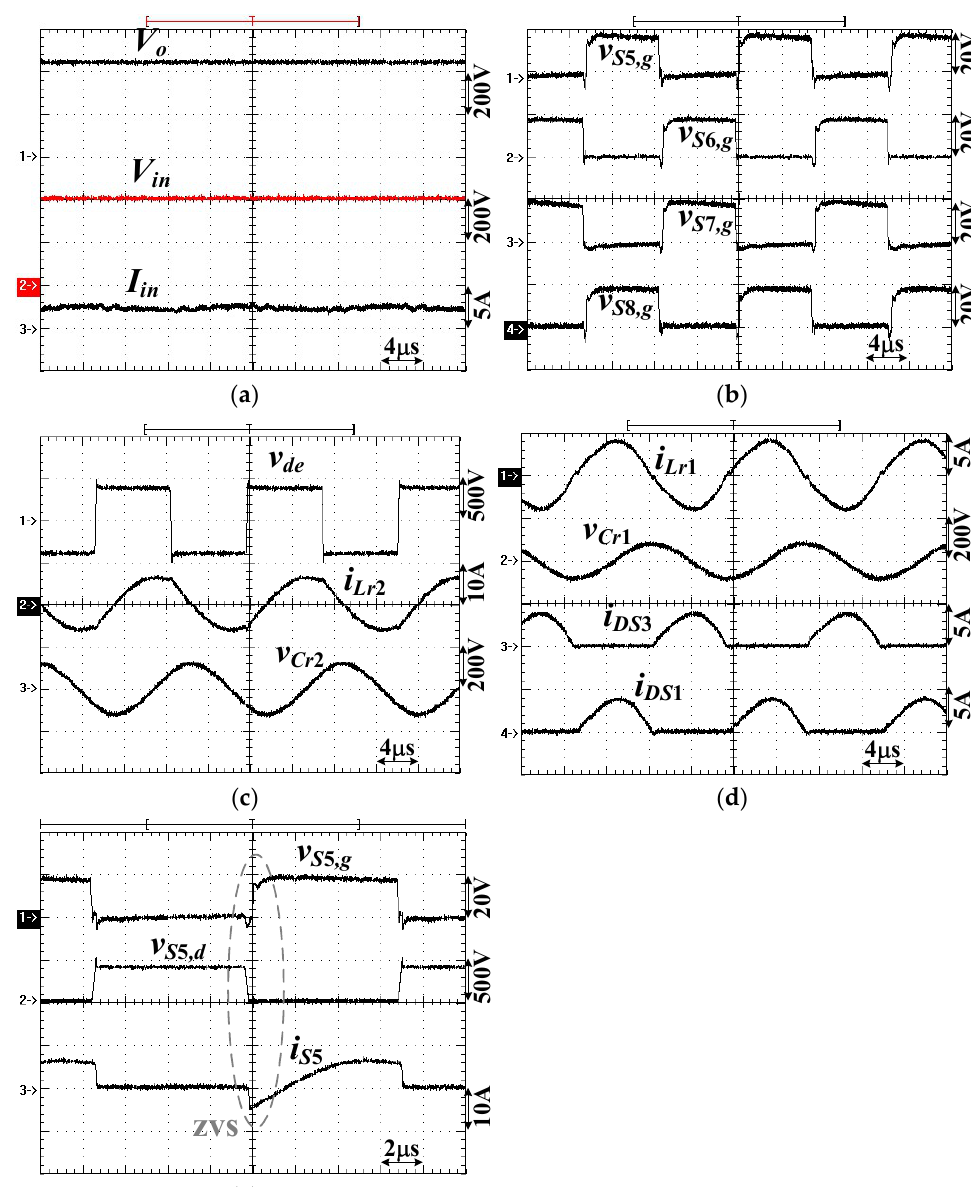
Figure 15. Experimental waveform of the proposed converter operated at backward power flow from V o = 450 V to V in = 400 V under the rated power condition ( a ) V o , V in , and I in ; ( b ) v S 5, g – v S 8, g ; ( c ) v de , i Lr 2 , and v Cr 2 ; ( d ) i Lr 1 , v Cr 1 , i DS 3 , and i DS 1 ; ( e ) v S 5, g , v S 5, d , and i S 5